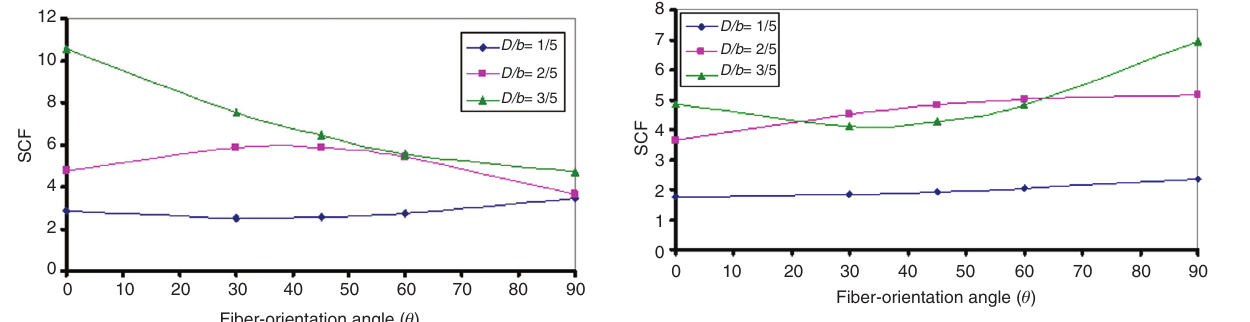
Figure 6 Effect of fiber orientation angle ( θ ) on SCF for a / b = 1.5 using graphite/epoxy material.